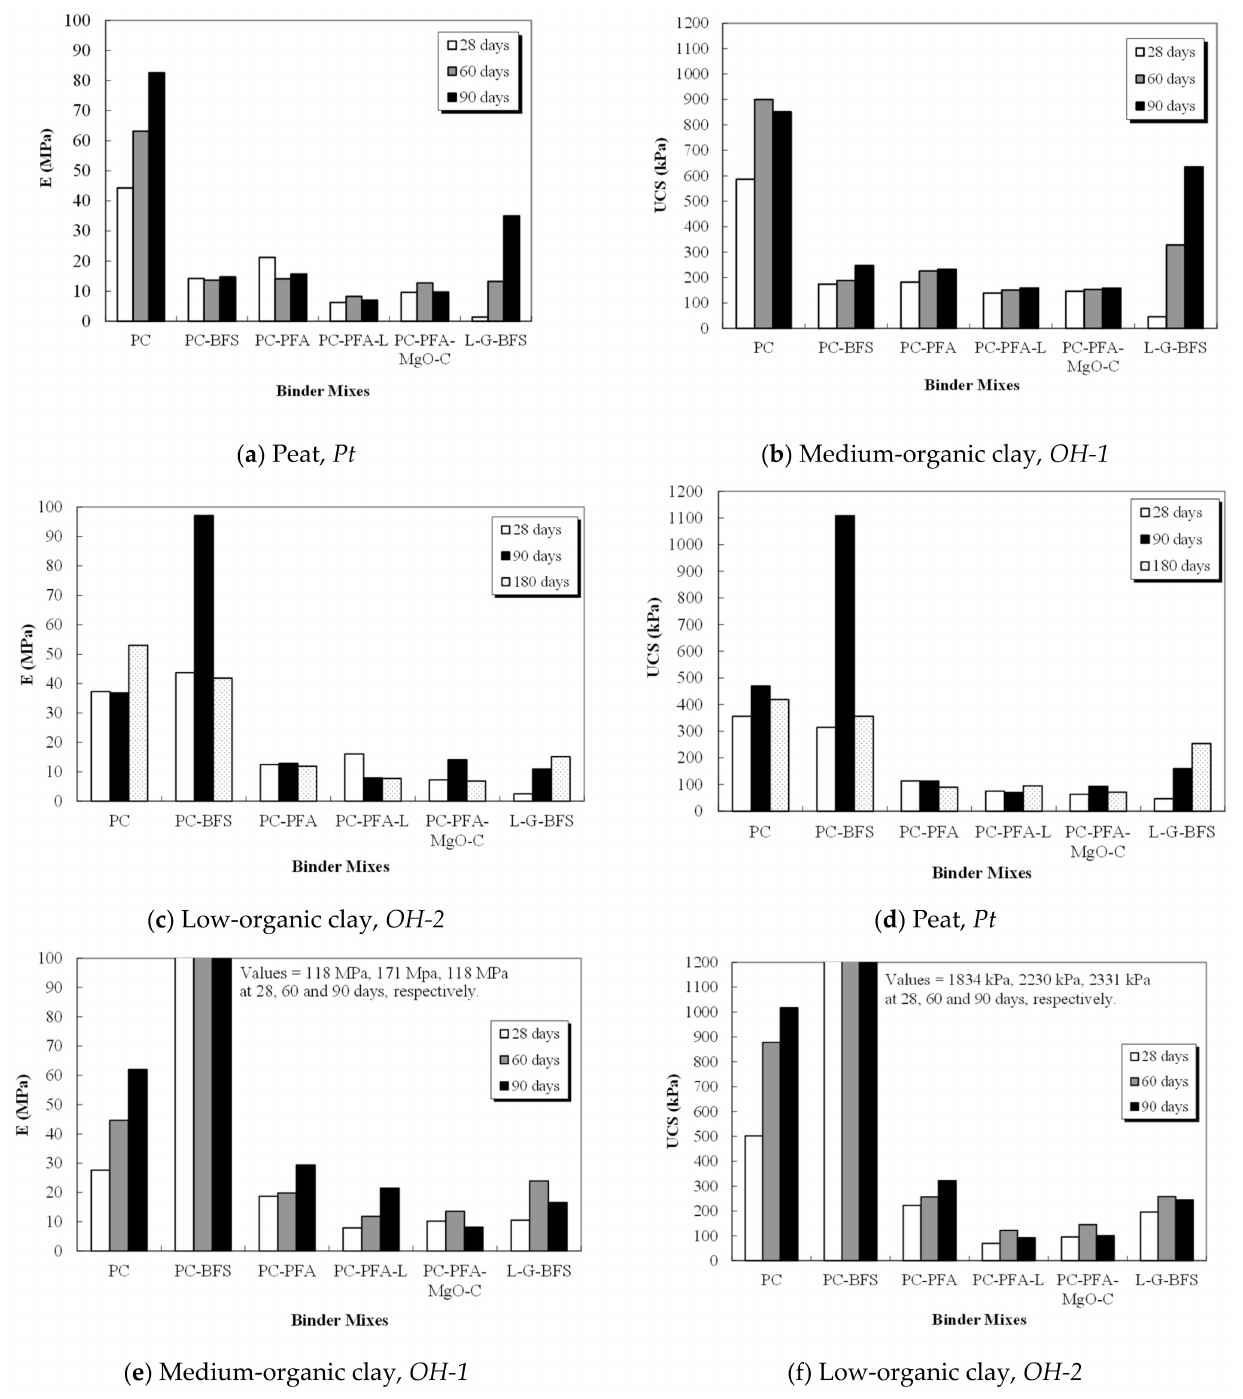
Figure 14. Stiffness and strength of stabilized organic soils using different binders: ( a ) and ( d ): Pt ; ( b ) and ( e ): OH-1 clay; ( c ) and ( f ): OH-2